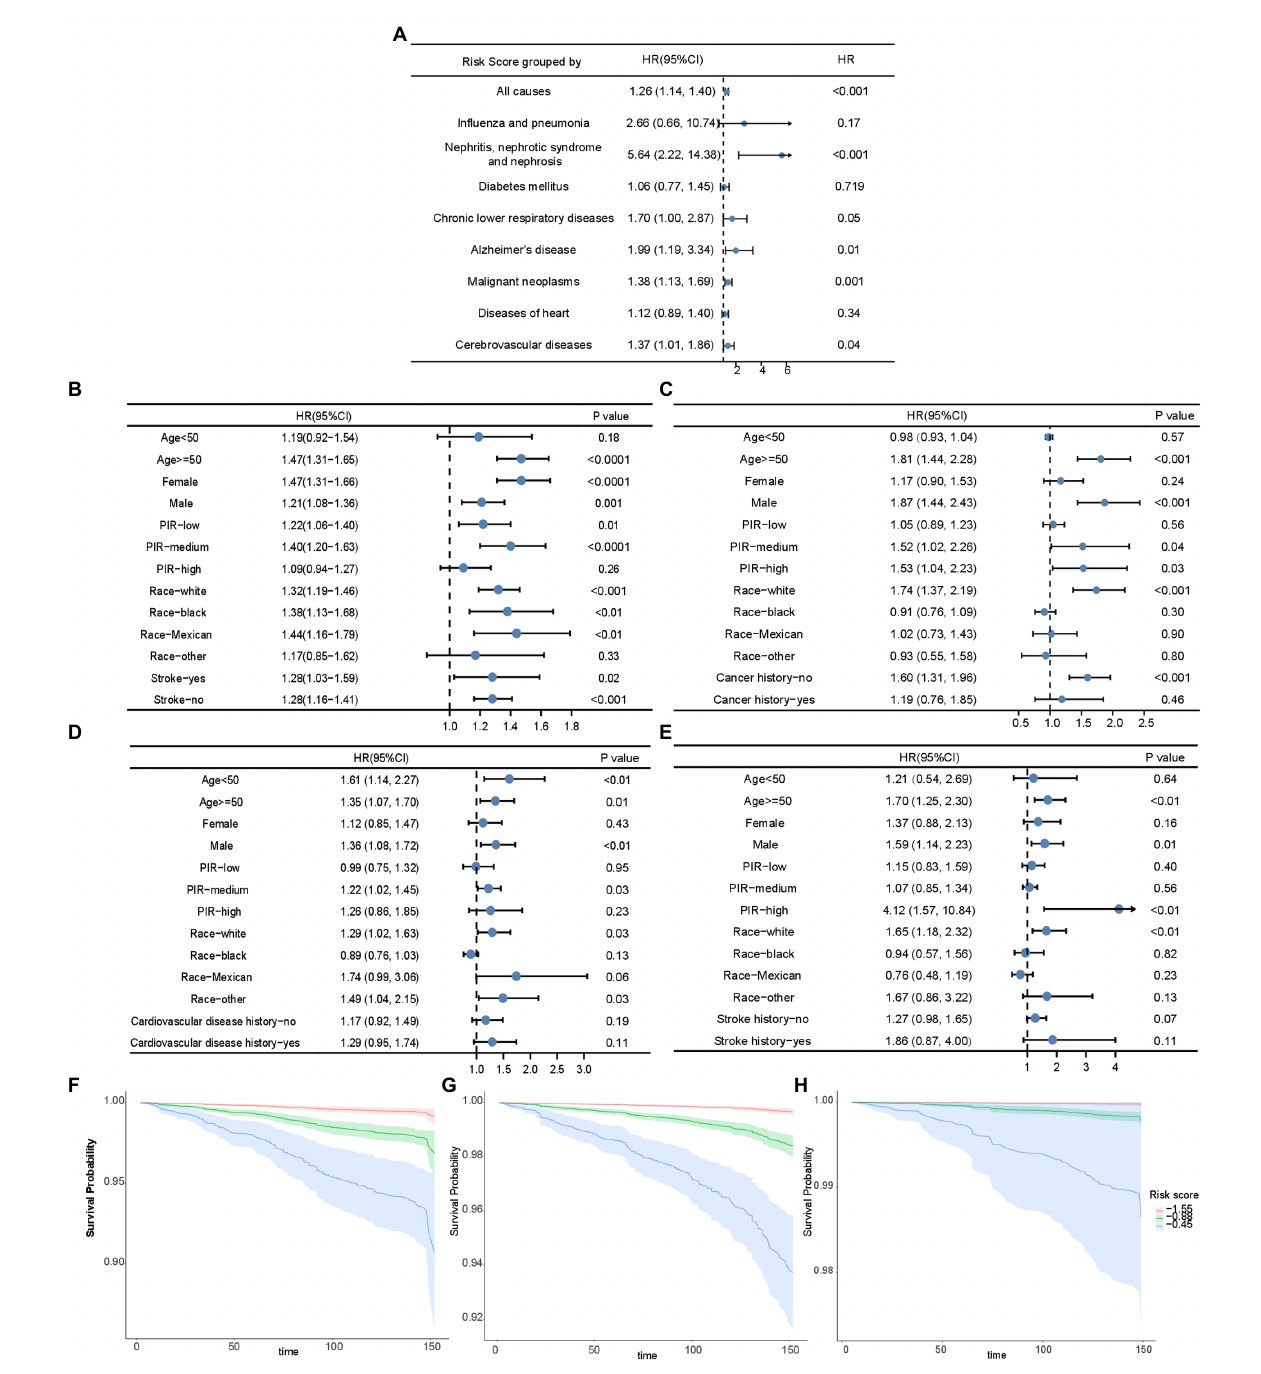
FIGURE 5 The association of risk score and mortality. (A) The forest plot displaying the association between risk score and all-cause mortality and disease-specific mortality in Cox analysis adjusted for age and PIR. The forest plots demonstrating the association between risk score and all-cause mortality (B) , cancer- related mortality (C) , mortality of heart diseases (D) , and mortality of cerebrovascular diseases (E) in unadjusted Cox analysis stratified by age, sex, PIR, race, and disease history. Kaplan–Meier curves based on risk score quartiles to demonstrate the death possibility caused by cancer (F) , heart diseases (G) , and cerebrovascular diseases (H) , after adjustment for PIR and age. HR: Hazard ratios; PIR: poverty income